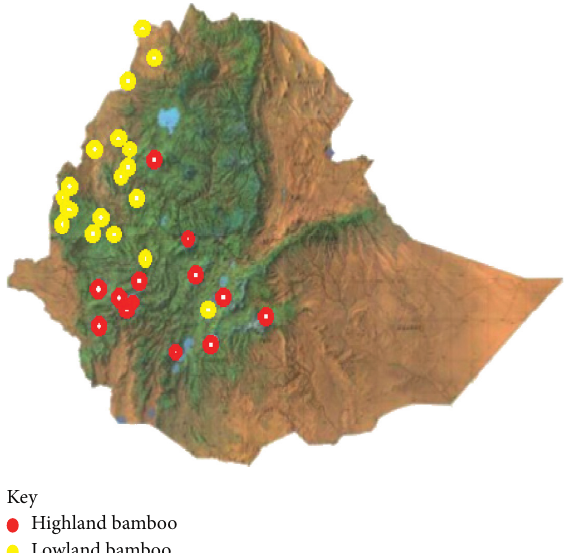
Figure 6: Geographical distribution of O. alpina and O. abyssinica in Ethiopia. Origin: indigenous to Ethiopia and endemic to Africa [13, 14].